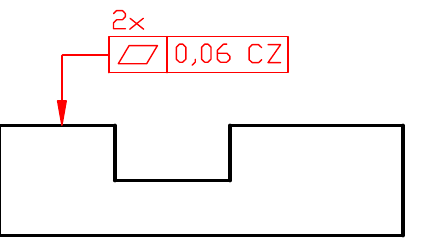
Figure 8. The combination specification element CZ in the ISO GPS system controls top surfaces in the same way as the ASME Y14.5 specification given in Figure 7a.